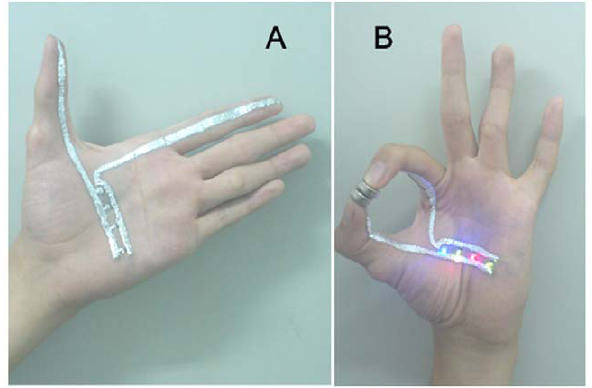
Figure 6. The skin circuit drawn in the palm. (A) The basic circuit drawn in the palm; (B) The circuit works when the batteries are gripped and the hand forms a gesture of ‘‘OK’’.